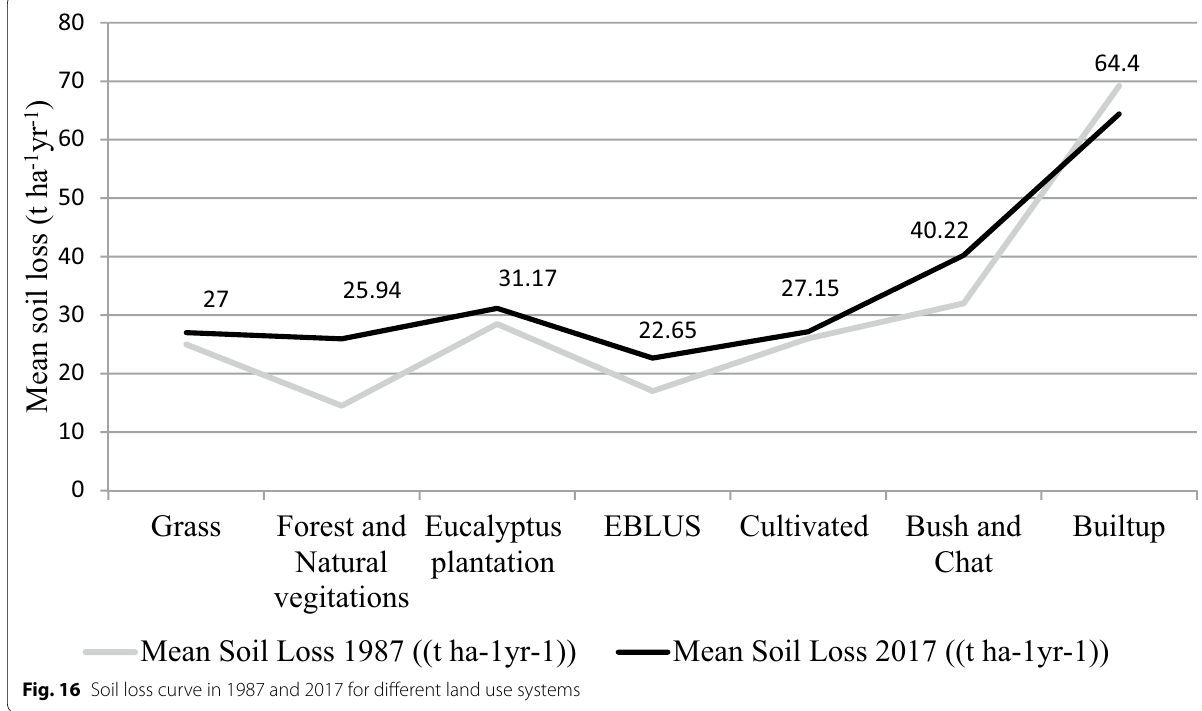
Fig. 16 Soil loss curve in 1987 and 2017 for different land use systems